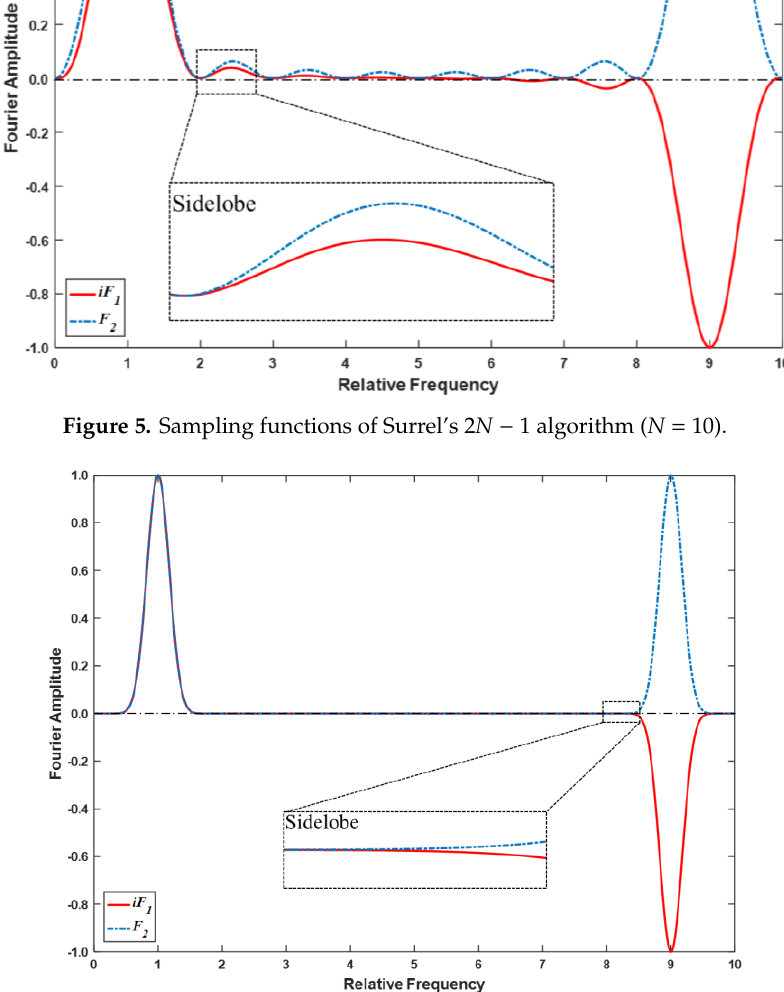
Figure 5. Sampling functions of Surrel’s 2 N − 1 algorithm ( N = 10).